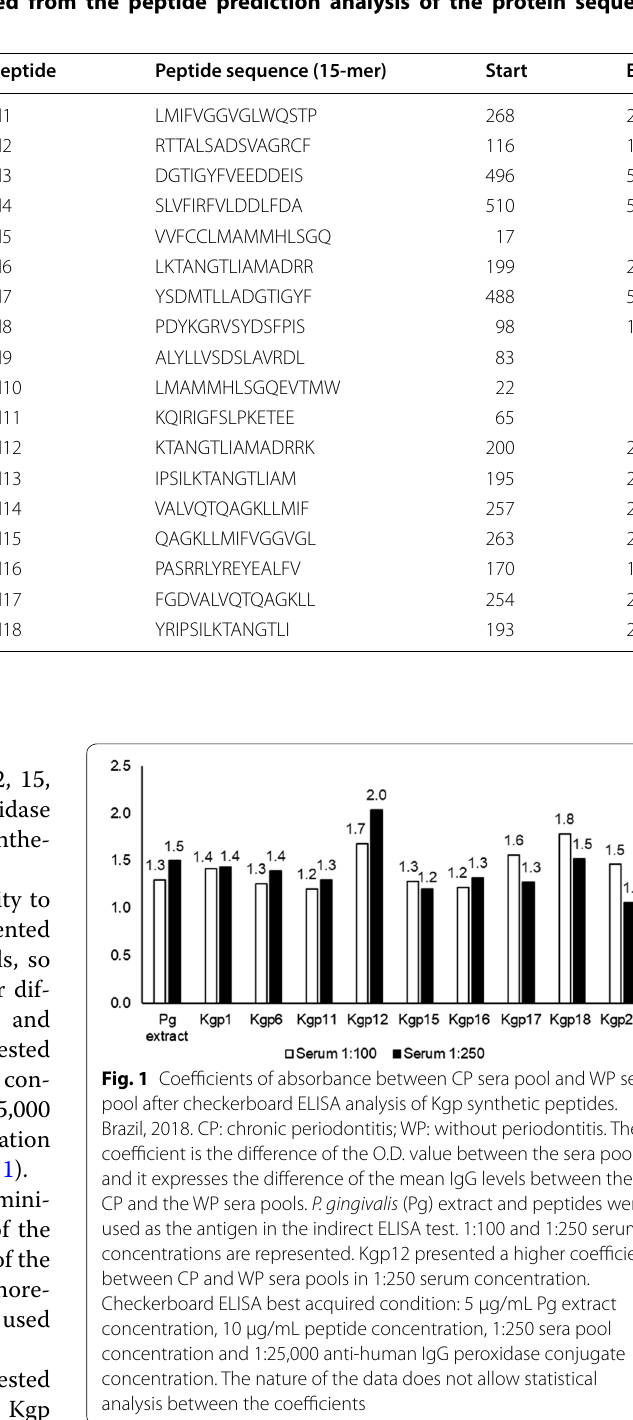
Table 3 Putative epitopes of neuraminidase obtained from the peptide prediction analysis of the protein sequence (Brazil, 2018) Protein HLA allele/haplotype